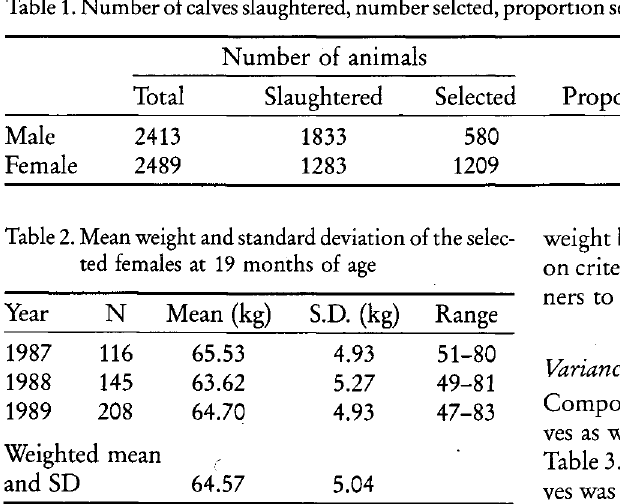
on criterion, thereby encouraging the reindeer ow ners to weigh their animals.